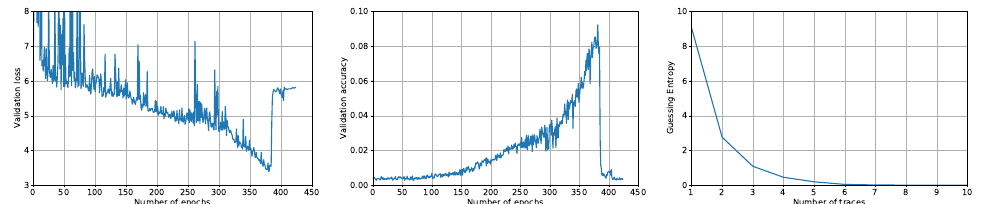
Figure 8: Results of synchronized ASCAD v1.